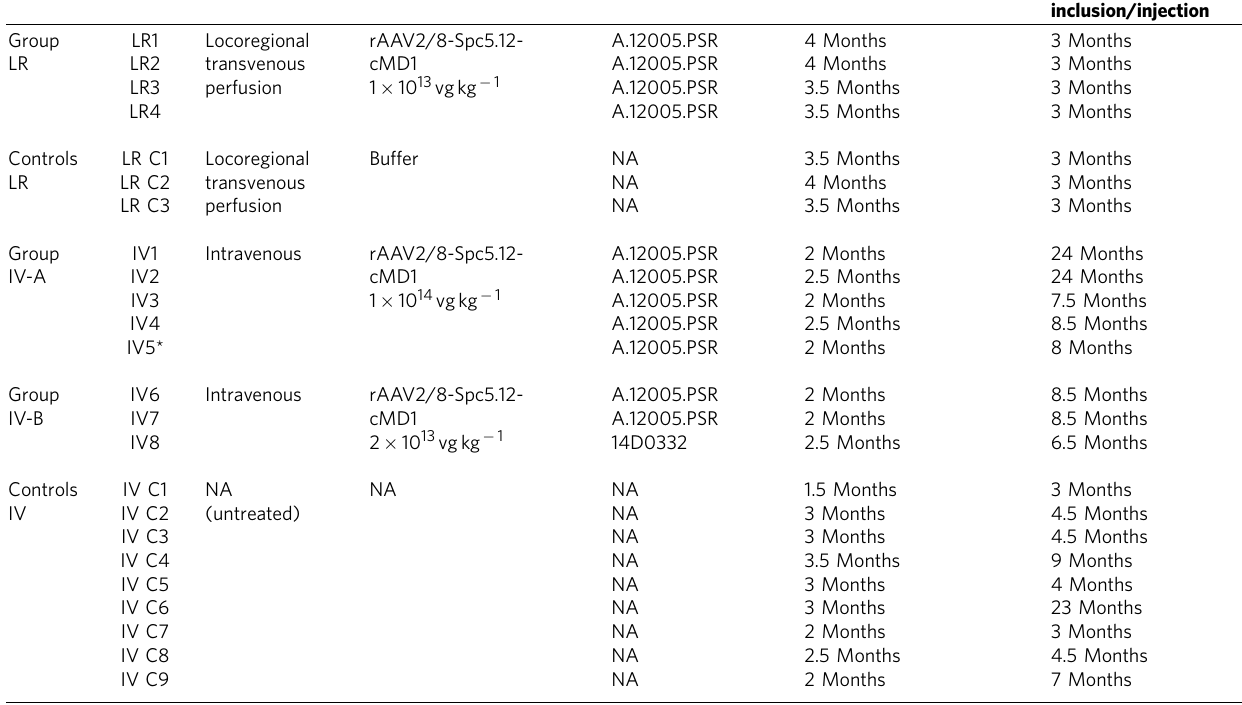
NA, not applicable. *At 2 months post injection, accidental fracture of the left